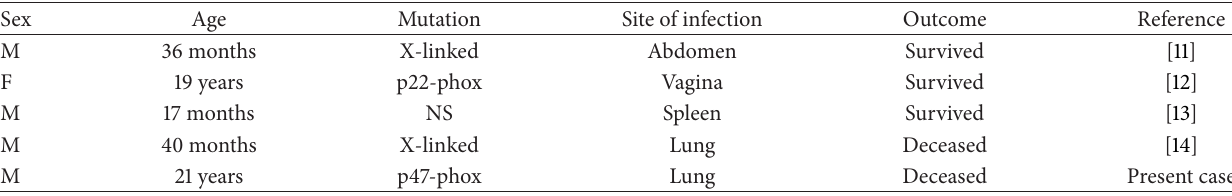
M 21 years NS: non